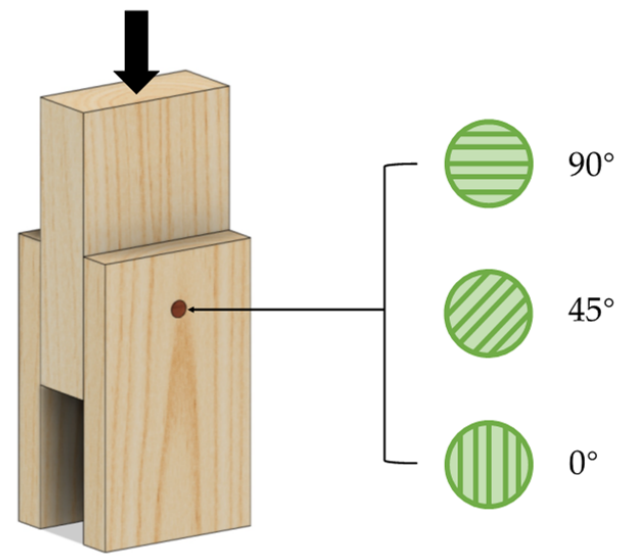
Figure 11. Dowel orientation in relation to the load direction in a double wood-to-wood shear test.